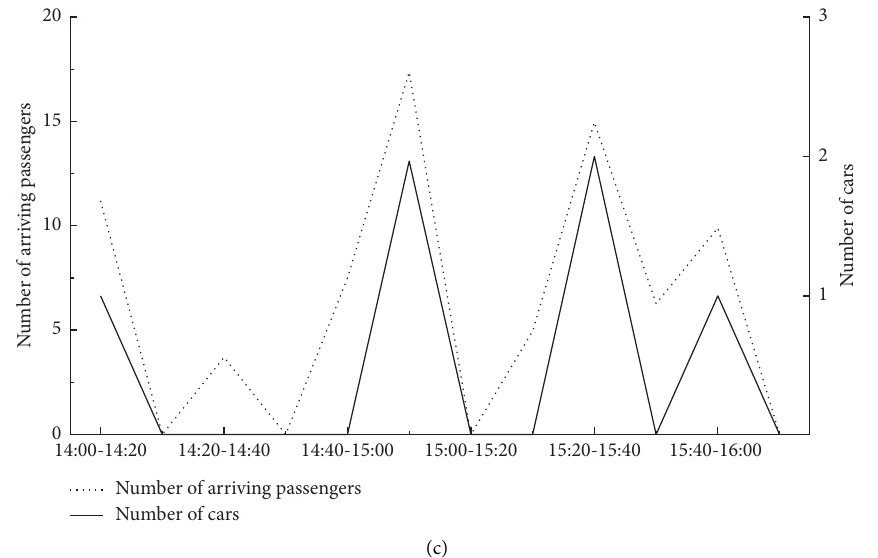
Figure 5: The matching of the optimized departure plan and passenger flow arrival after different routes. (a) Long-distance passenger transport line-matching analysis. (b) Analysis of two matches of long-distance passenger transport lines. (c) Analysis of three matches of long-distance passenger transport lines.